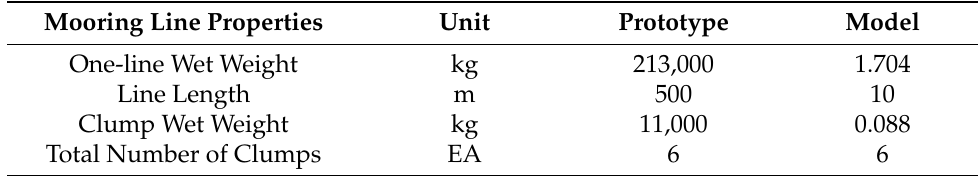
Figure 12. Configuration of semi-submersible and mooring line. Table 5. Specifications of mooring lines (scale 1:50).